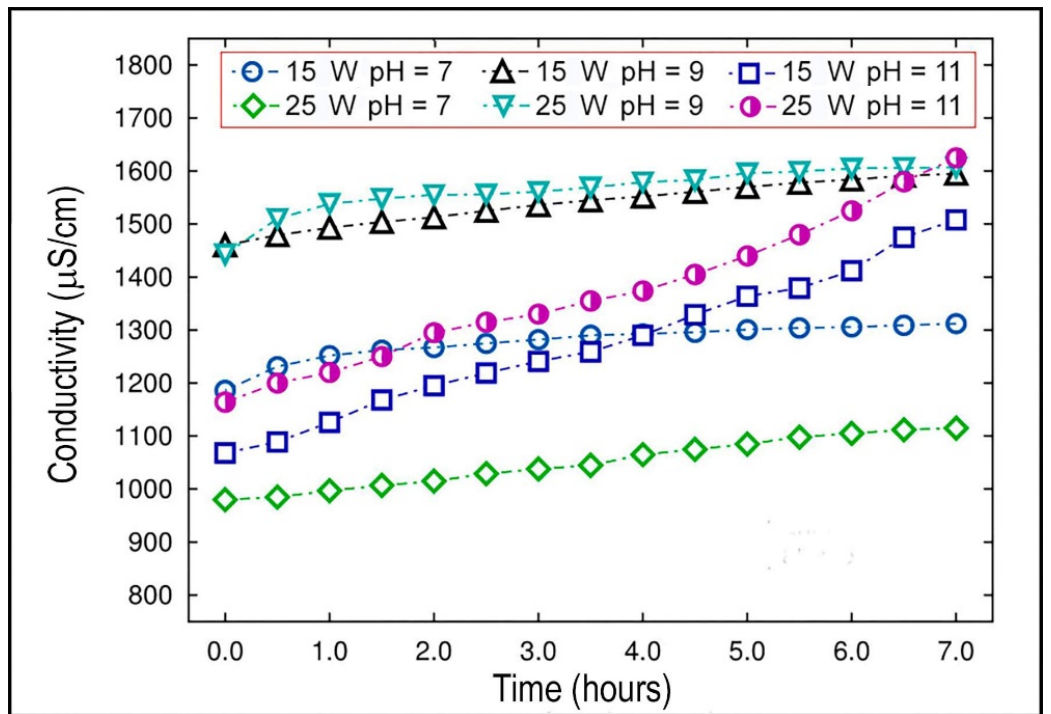
Figure 3. Dynamics of sample conductivity during NH 4 + /NH 3 removal process by photocatalysis. Q = 1000 L/h, temperature = 20 ± 1 ◦